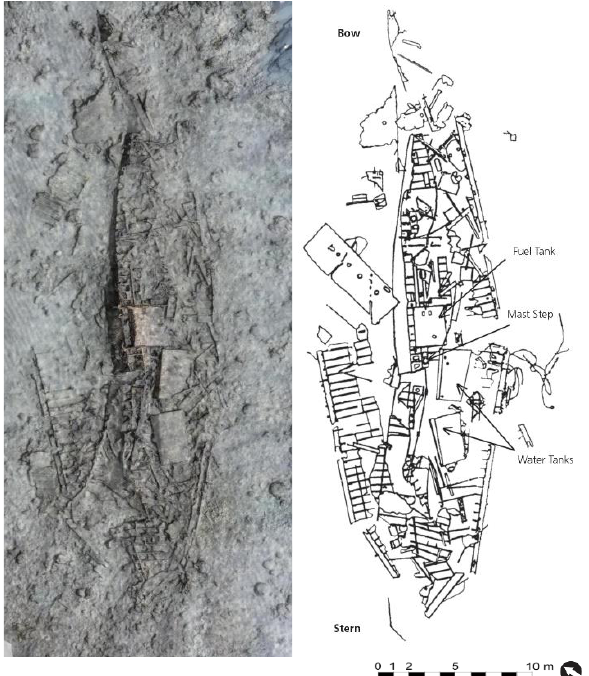
Figure 14. On the left, orthophoto of the Mandalay (70% transparency) superimposed over its hillshade DSM in order to make the 3D features more relevant; On the right, archaeological drawing of the site (Image courtesy of the National Park Service ). It is possible to notice several differences between the 2020 orthophoto and the archaeological survey (produced several years